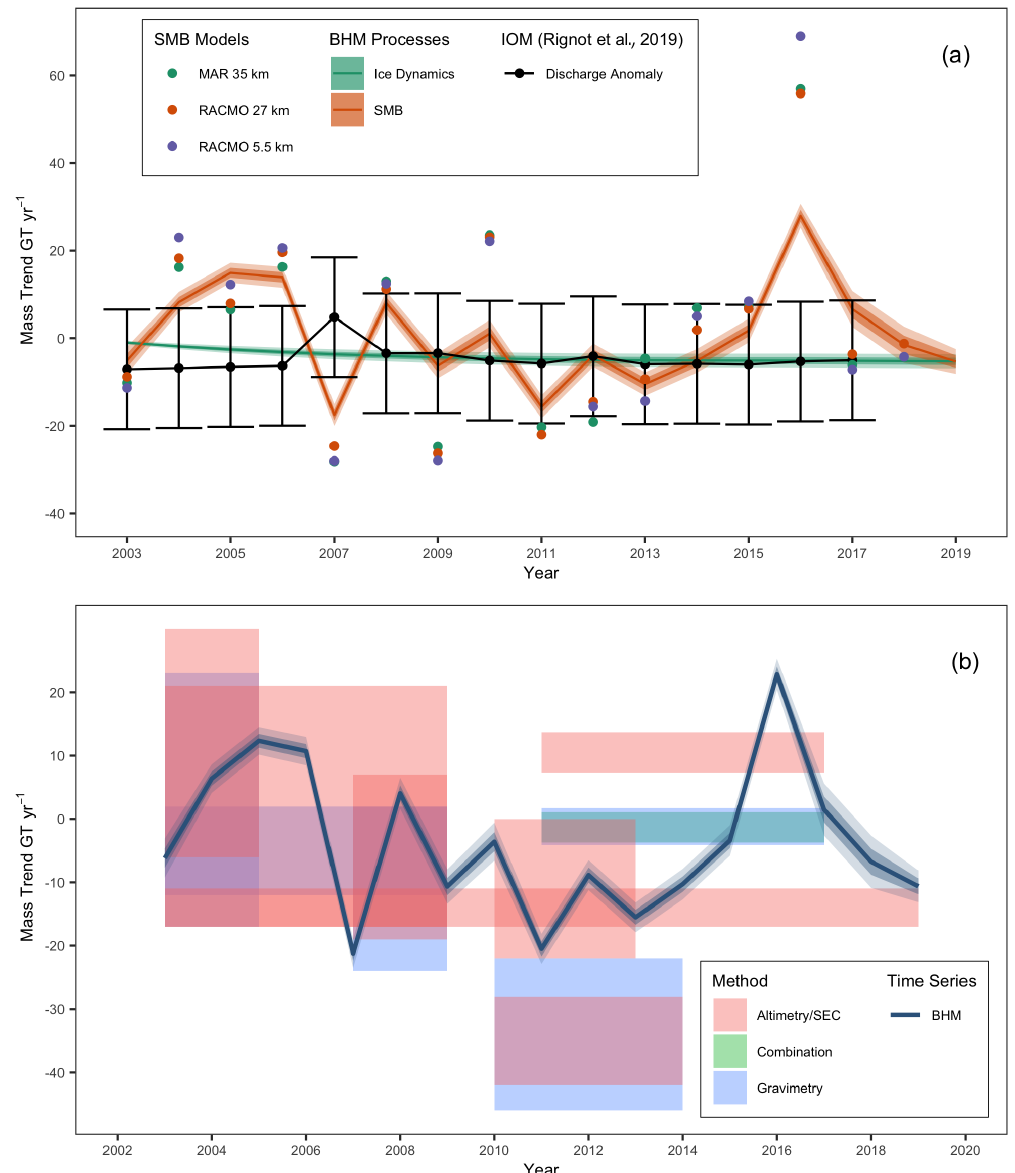
Figure 9. (a) Surface processes and ice dynamics mass trends for the Hp-I drainage basin (West Palmer Land and English Coast region) line plots, with shaded ribbons representing 1 σ and 2 σ uncertainties on the process posterior from the BHM. Scatter points represent RCM mass anomalies with respect to a 1979–2002 baseline (Agosta et al., 2019; van Wessem et al., 2016, 2018), and the grey line represents the annual ice discharge anomaly with respect to a 1979–2002 baseline value, with one 1 σ uncertainty on the discharge represented by the crossbars (Rignot et al., 2019). (b) Comparison of total mass trends for basin Hp-I from the BHM (blue line, with 1 σ uncertainty ribbon) with time-averaged epoch studies for the same sector (colour shaded boxes – see Table S2 for list of studies). Details of the processing for the comparison datasets can be found in Sect.